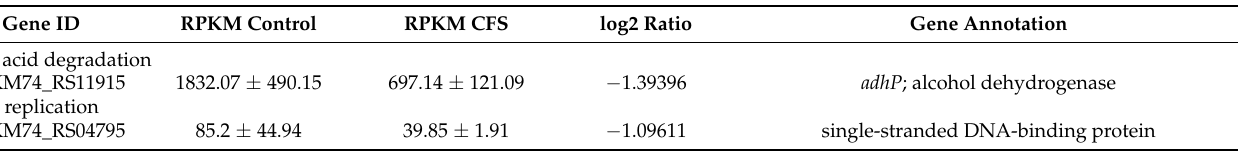
Table 1. Gene annotation and KEGG pathway of the differentially expressed genes in E. coli ATCC25922 in response to CFS from L. rhamnosus SCB0119. Table 2. Gene annotation and KEGG pathway of the differentially expressed genes in S. aureus ATCC6538 in response to CFS from L. rhamnosus